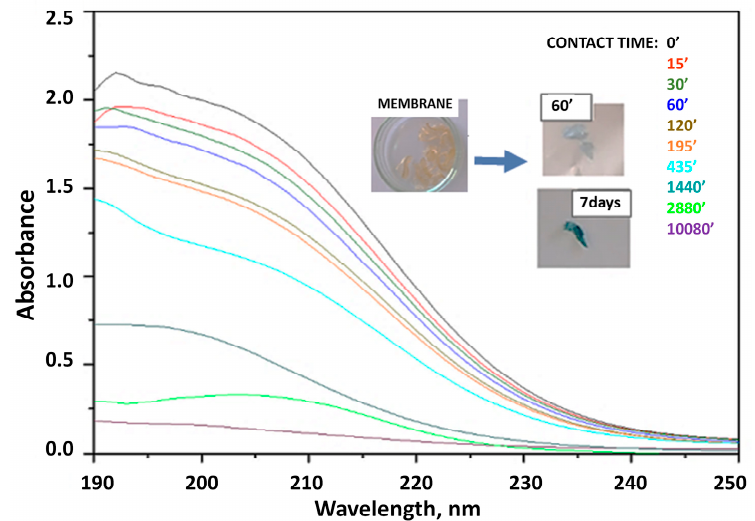
Figure 8. UV-vis spectra of aqueous CuSO 4 1.5 mM solution before and after immersion of the membrane Ch-NH 2 /P(DMAM-co-GMA) 9:1 with increasing contact